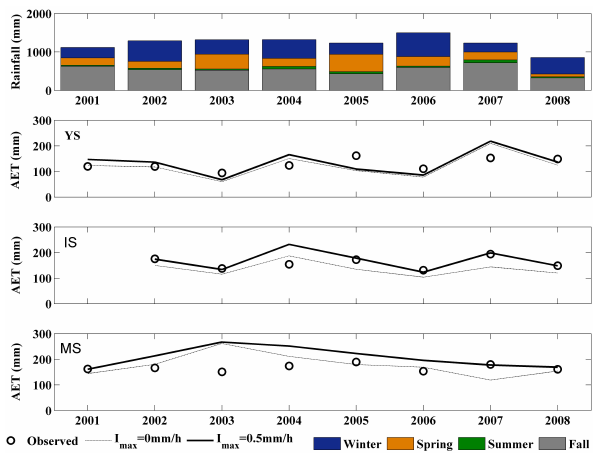
Fig. 5. Nash-Sutcliffe efficiency for seasonal simulations with (a) I max =0mmh − 1 and (b) I max =0.5mmh − 1 . AET modelled with 1t